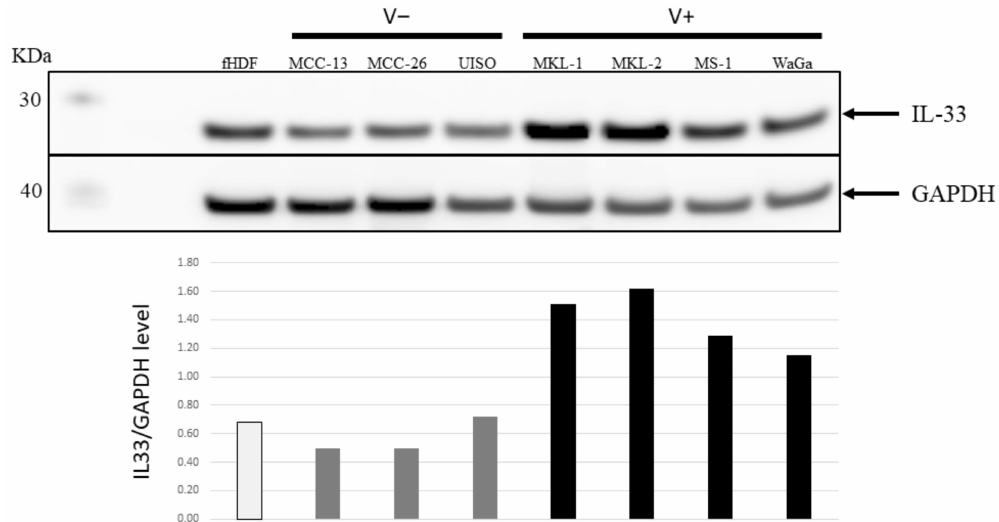
Figure 2. IL-33 expression levels in V − and V+ MCC cell lines. Top panel: Western blot analysis of IL-33 expression in V − MCC (MCC-13, MCC-26, and UISO) and V+ MCC (MKL-1, MKL-2, MS-1, and WaGa) cell lines. Immortalized human dermal fibroblasts (fHDF) were used as control cells and GAPDH was used as a loading control. Bottom panel: ratio of the values obtained by densitometric scanning of the signals obtained with IL-33 and GAPDH